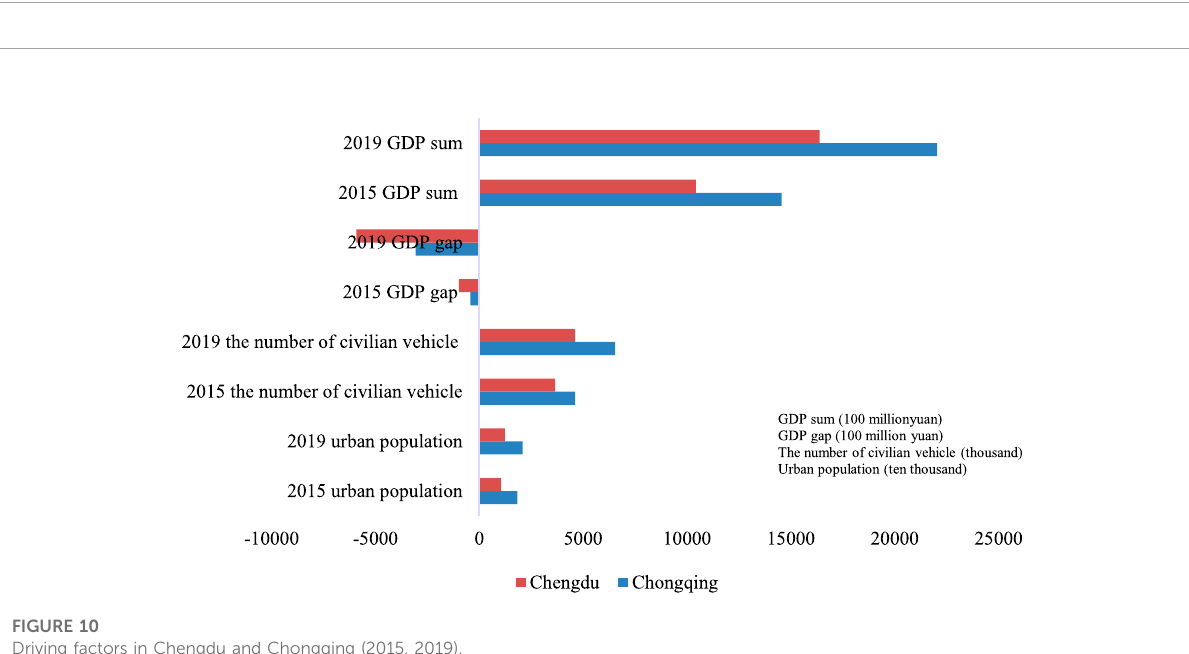
FIGURE 10 Driving factors in Chengdu and Chongqing (2015, 2019).